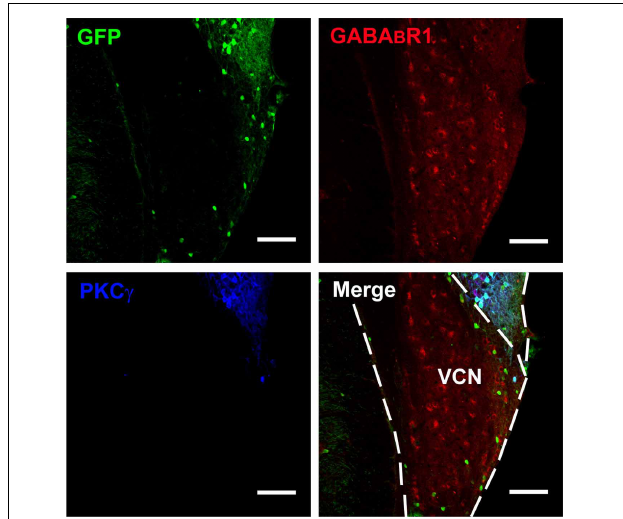
FIGURE 2 | Photomicrographs representing sections of the brainstem of GAD67-GFP knock-in mice in the VCN. Fluorescent photomicrographs showing the distribution of GFP (green), GABA B R1-positive (red), and PKC γ -positive (blue) cells in the VCN of the GAD67-GFP knock-in mice. Triple-labeled neurons for GFP/GABA B R1/PKC γ were rare in the VCN. The bottom of the DCN can also be observed. Scale bar: 100 μ m.